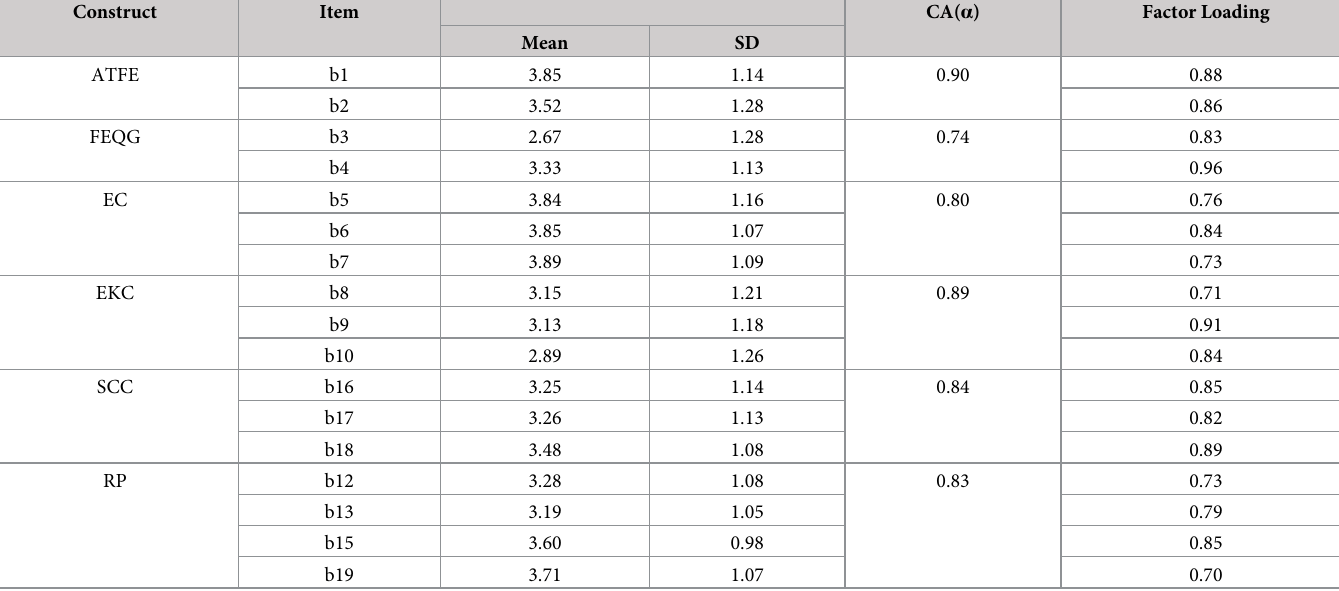
Table 2. Descriptive statistics.